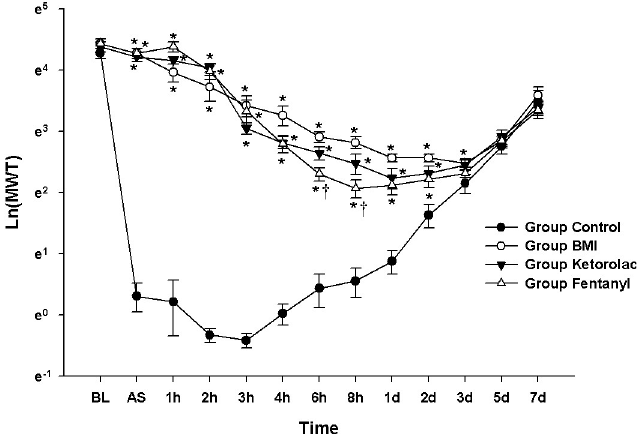
Fig 5. Comparison with positive control groups. The graphs are presented as means ( ± standard error of the mean) of the mechanical withdrawal threshold with von Frey filaments. Mechanical withdrawal threshold with von Frey filaments. BL: baseline, AS: after surgery. � P < 0.05 compared with Group Control, † P < 0.05 compared with Group BMI.